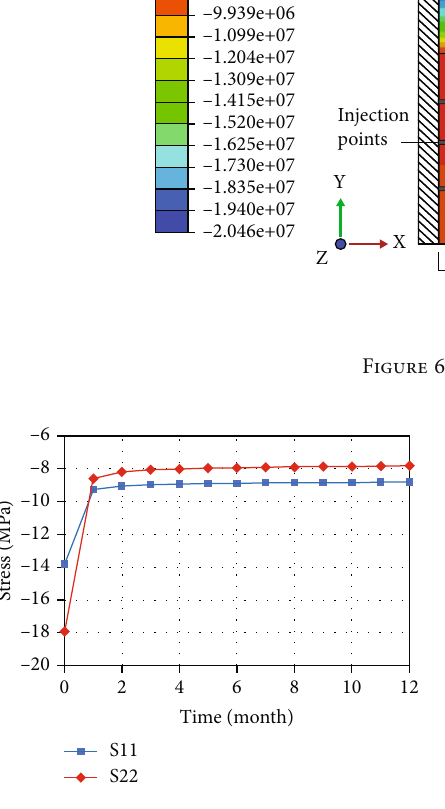
Figure 7: Curve of the stress fi eld with injection